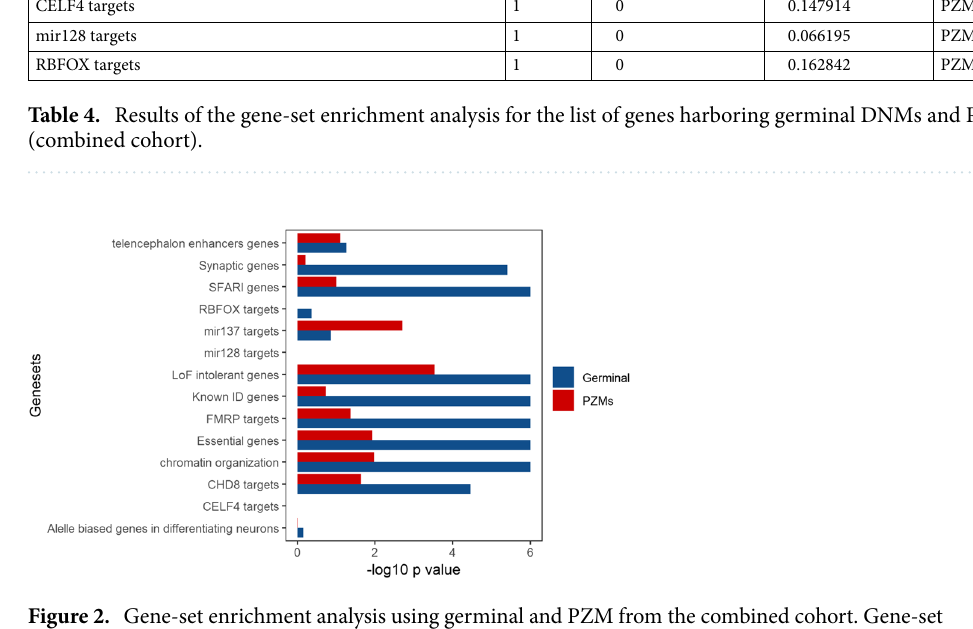
Figure 2. Gene-set enrichment analysis using germinal and PZM from the combined cohort. Gene-set enrichment analysis was done with DNENRICH. − log10 p value for each gene-set is shown for each type of mutation and tested